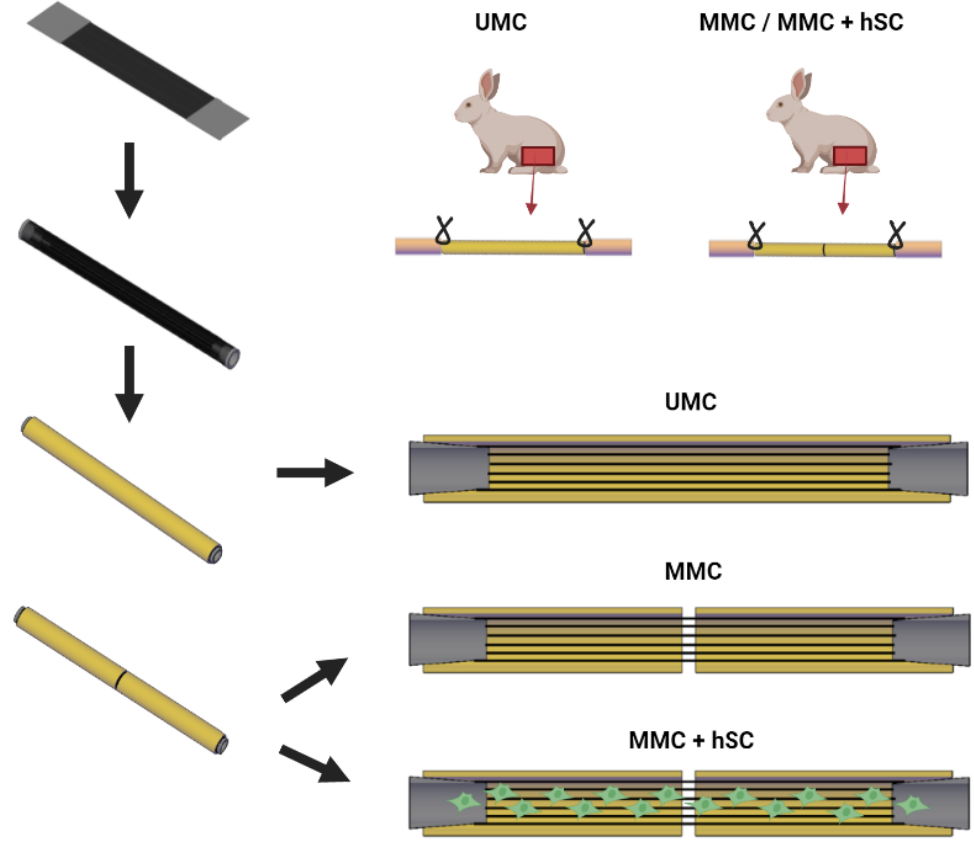
Figure 2. Scheme representing the differences among the three different guidance conduits that are studied. For all groups, the starting point is a PLA planar microfiber bundle formed by 3600 parallel PLA microfibers with a diameter of 10 microns each. The bundle is rolled up to obtain a cylindrical bundle. For the unimodular conduit (UMC) group, the PLA microfiber bundle is inserted into a 15 mm-long HA conduit. For the multimodular conduit (MMC), the PLA microfiber bundle is inserted into two consecutive HA conduits with a length of 7.5 mm each. The multimodular conduit plus human Schwann cells (MMC + hSC) is obtained in the same way as the MMC, but it was pre-seeded with 1.25 × 10 6 human Schwann cells (hSC) 10 days before the implantation. At both extremes of the conduits, a 2.5 mm-long ring maintains the structure of PLA microfibers and allows the suture to the nerve stump that is inserted into it. The total length of the implant is of 20 mm. All three types of implants are used to bridge a 15 mm-long sciatic nerve defect in rabbits. Picture created with BioRender.com.